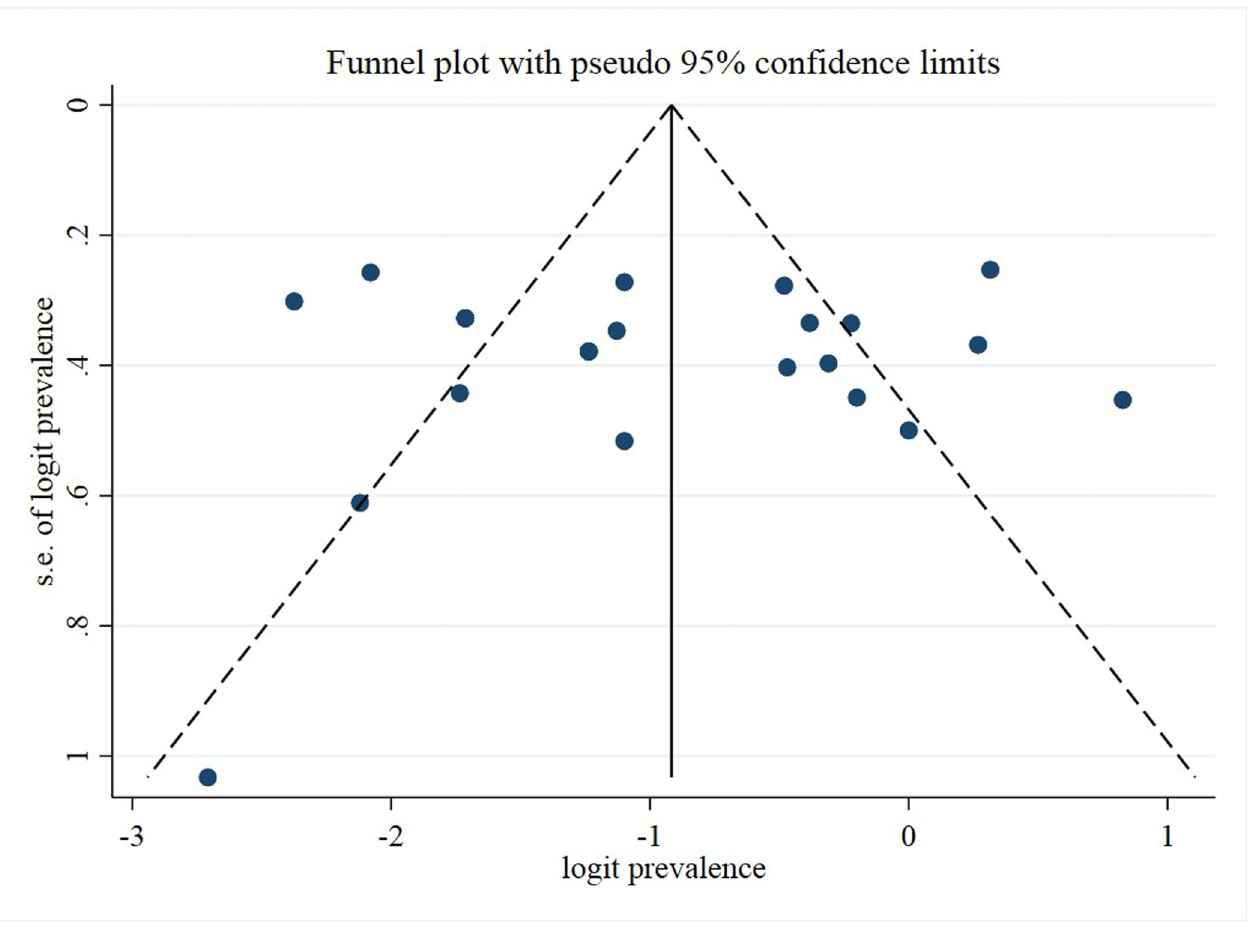
Fig 4. The funnel plot showing no evidence of publication bias, statistically supported by Egger’s regression test.